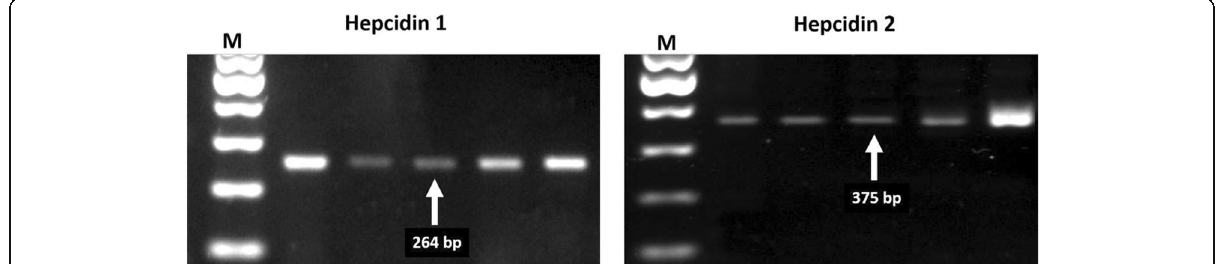
Fig. 1 Agarose gel electrophoresis of hepcidin 1 (264 bp, left panel) and hepcidin 2 (375 bp, right panel)-PCR fragment. M, 100 bp DNA